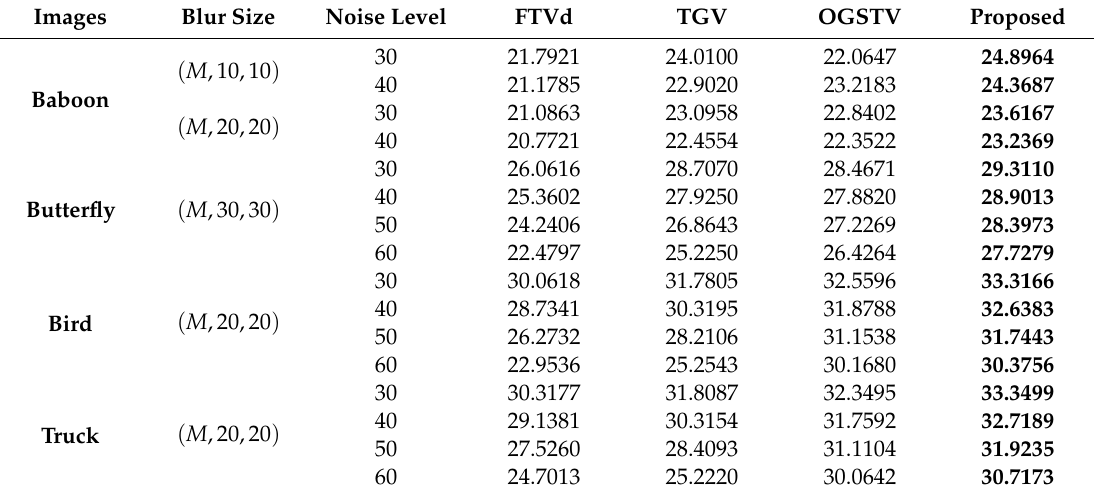
Table 5. Numerical results of PSNR (dB) for the image restoration test conducted on four test images degraded with di ff erent levels of blur and impulse